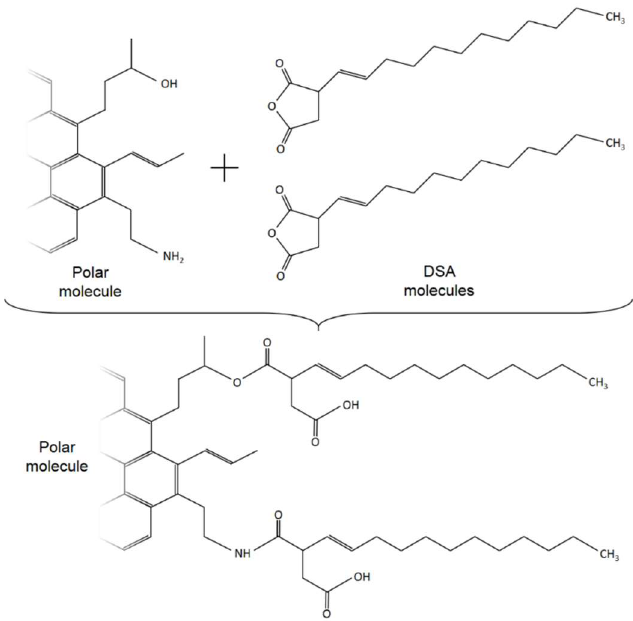
Figure 12. Expected chemical reactions between DSA and bitumen polar molecules.